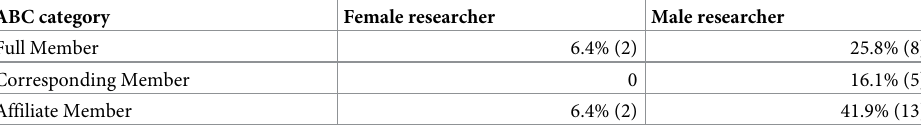
Table 2. Male and female researchers as members of the Brazilian Academy of Sciences (ABC) considering differ- ent categories. Proportions consider the total researchers in Entomology (30), numbers in parentheses are the abso- lute values.